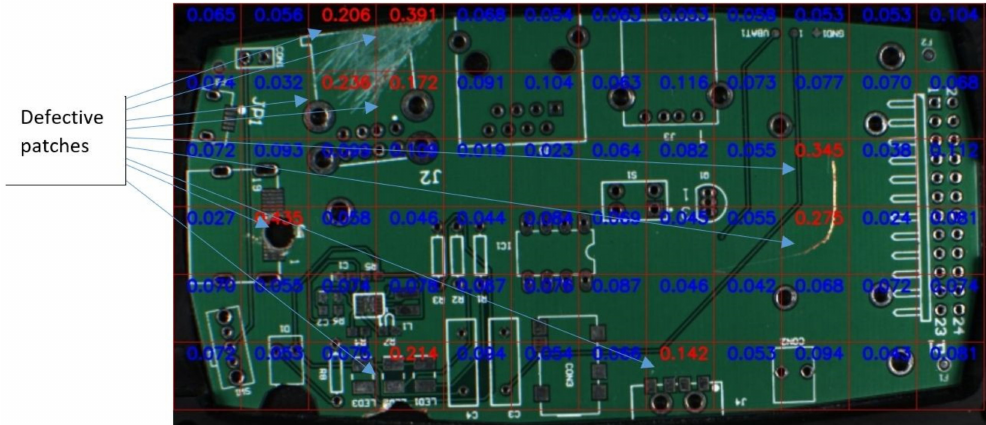
Figure 6. The number in each patch is a distance to the normal cluster. Blue number areas are identified as normal, red ones are identified defective (the distance is above a